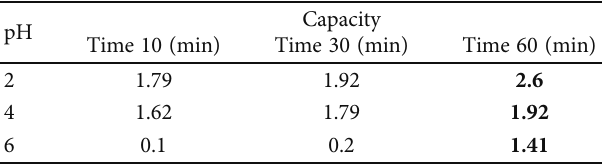
Table 1: The amount of cadmium that was adsorbed with the change of the pH function and the immersion time in a 10 ppm solution.